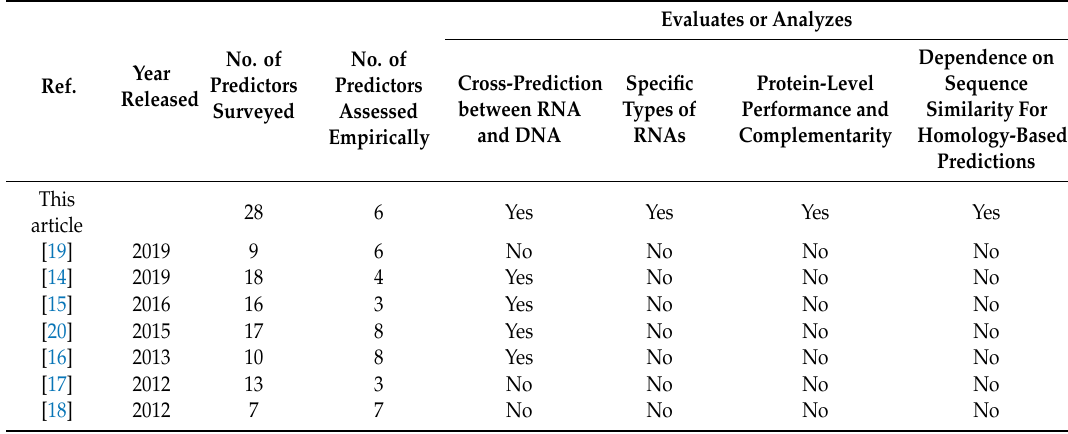
Table 1. Surveys of the sequence-based predictors of RBRs. While some of these surveys cover the structure-based methods and methods that consider protein-DNA interactions, we specifically focus on their coverage of the sequence-based predictors of